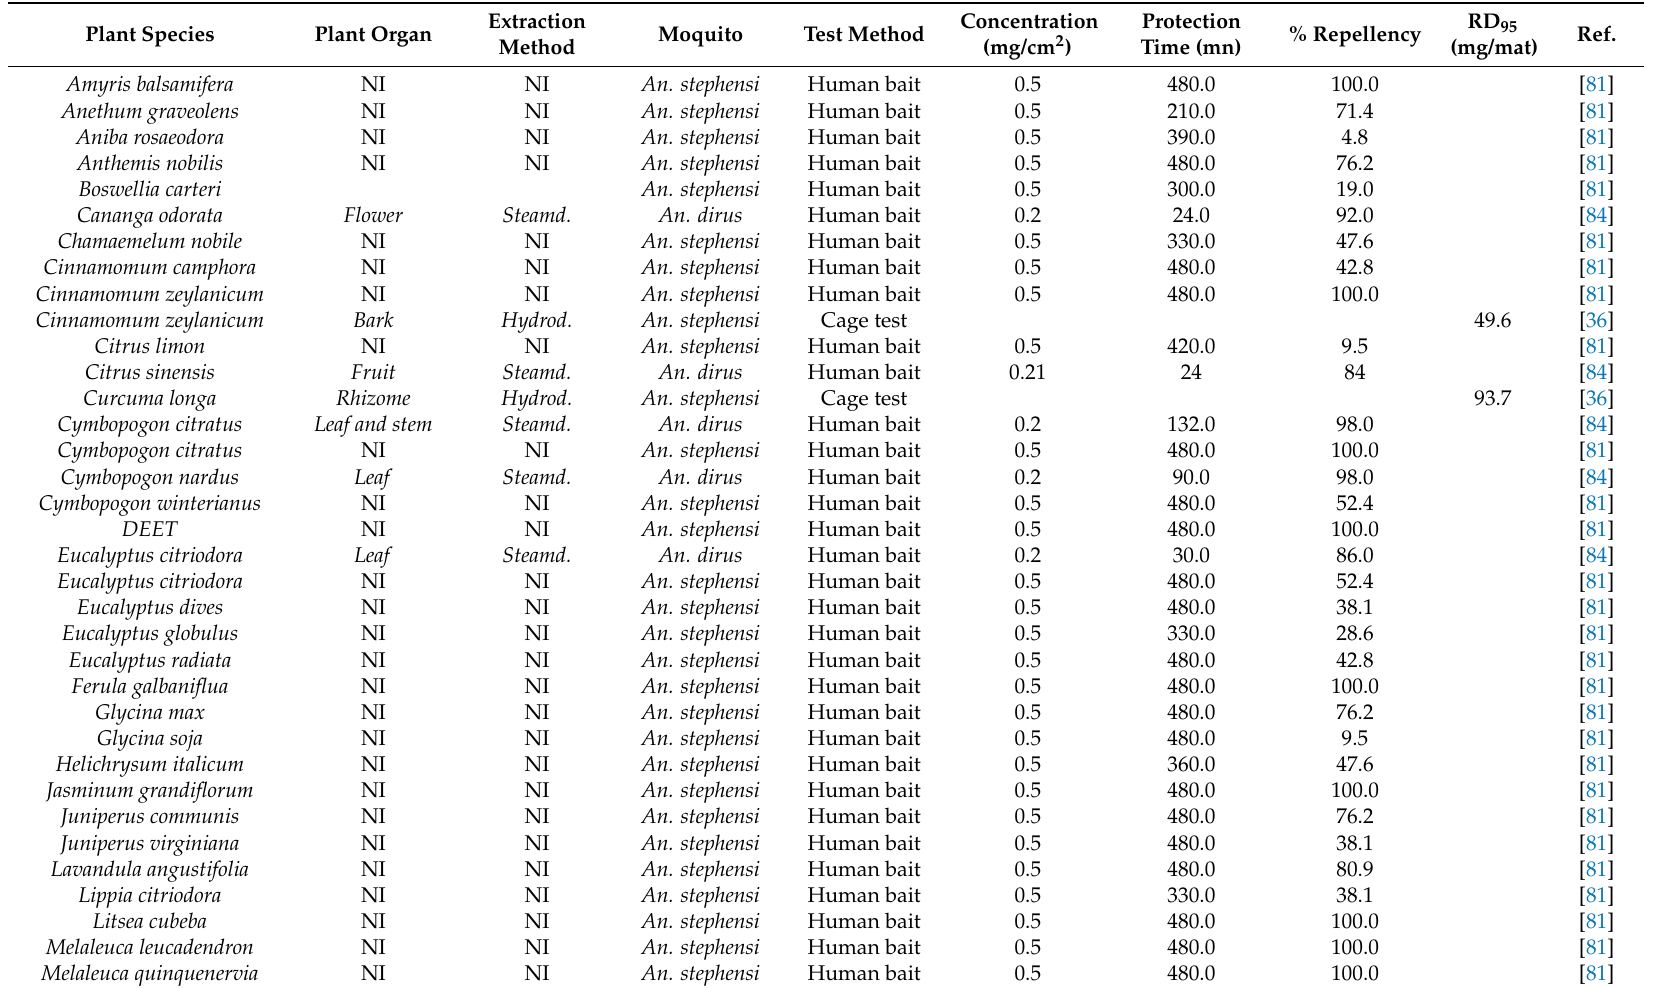
Table 5. Plant essential oils with high repellency to Anopheles